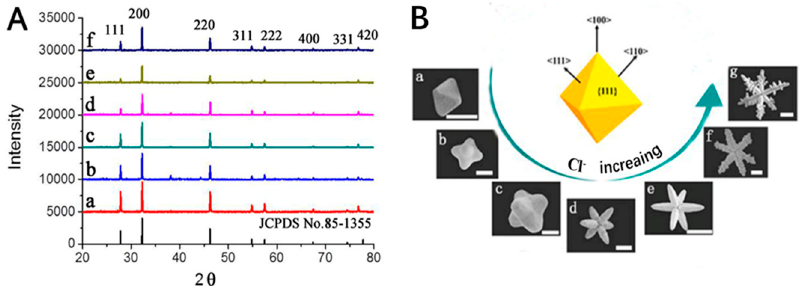
Figure 3. ( A ) XRD of the as-prepared AgCl microcrystals; ( B ) Schematic drawing shows facets and growth directions of 3D AgCl microstructures from octahedral seeds. Scale bar: 2 µ m ( a – d ); 10 µ m ( e – g ).